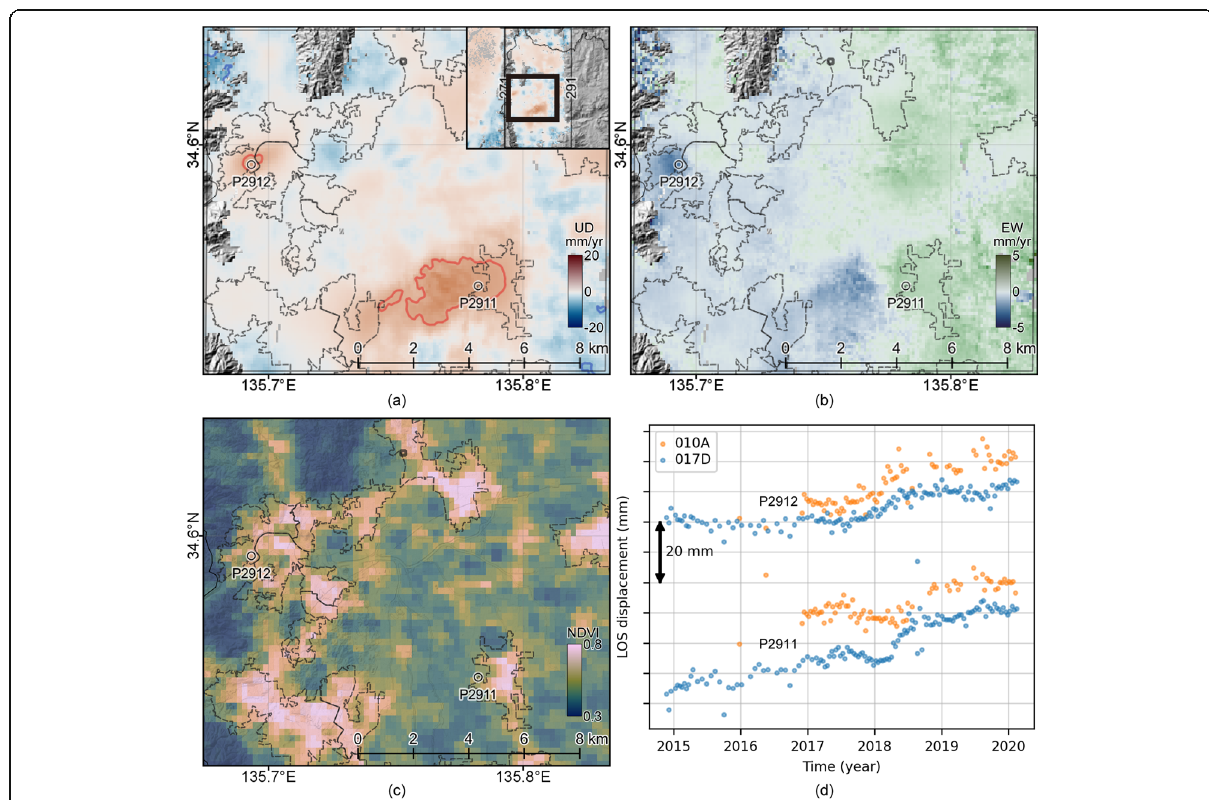
Fig. 13 a Vertical deformation velocities in a part of Nara prefecture (ID: 291). The black lines denote the outlines of the DID. The interval of the red (uplift) and blue (subsidence) contour lines is 5 mm/year without the 0 mm/year lines. The black square denotes the reference point. The inset denotes the whole area of the 291 Nara. b EW deformation velocities. c NDVI. ( d ) LOS deformation time series at P2912 and P2911 for each